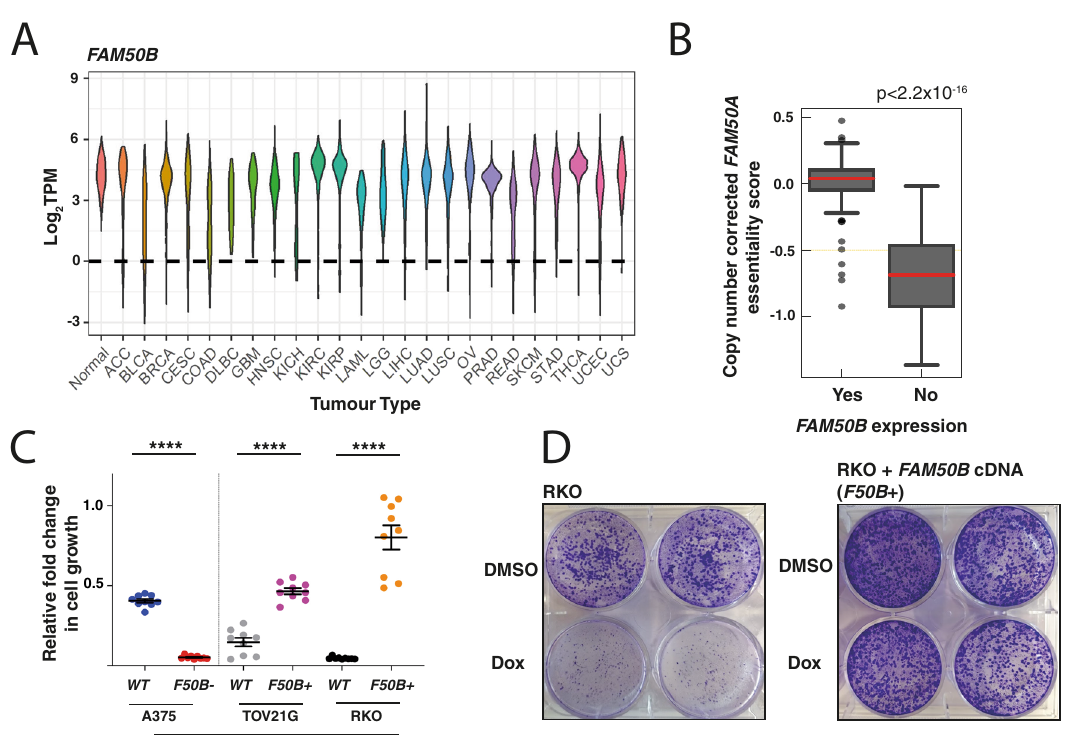
Fig. 3 The FAM50A/FAM50B axis is a targetable synthetic lethal interaction. A Expression of FAM50B across tumour and normal tissue. Data obtained from the TCGA 36 . TPM; transcripts per million. Standard TCGA tumour abbreviations where used. B FAM50B expression inversely correlates with dependency on FAM50A . These data were derived from the analysis of CRISPR essentiality in 275 cancer lines 34 . Lines were categorised by their FAM50B expression using an RPKM cutoff of 1 below which expression was de fi ned as absent. The dependency of FAM50A is shown as scaled log 2 fold-change of FAM50A gRNAs corrected for copy number variation across the cell lines used in this analysis. The p value was calculated with a two-tailed Mann – Whitney U test. Box-and-whisker plots show 1.5× interquartile ranges and 5 – 95th percentiles, centres indicate medians. C Analysis of essentiality using isogenic cell lines. TOV21G-Cas9 and RKO-Cas9, which do not express FAM50B , were transduced with a lentivirus expressing a FAM50B cDNA ( F50B + ). A375-Cas9 cells express both FAM50A and FAM50B . A FAM50B knockout clone was generated for this cell line ( F50B − ) using CRISPR. Cells were transduced with a BFP + lentivirus carrying a gRNA against FAM50A such that 50% of cells were transduced. Cell proportions were analysed at day 4 and 14. The relative fold-change of the infected population is shown. p values were obtained using the unpaired two-tailed t test, **** p < 0.0001. Experiments were performed on three separate occasions in triplicate. Error bars represent the mean and the standard error of the mean (SEM). D Clonogenic con fi rmation of the FAM50A/FAM50B genetic interaction. RKO and RKO- F50B + (complemented with a FAM50B cDNA) were transduced with a lentivirus containing a doxycycline-inducible gRNA against FAM50A (see Methods). The cells also constitutively expressed Cas9 protein. Cells were seeded at 1000 cells/well; doxycycline (Dox; 0.1 µ g/ml)/DMSO was added at 24 h. Cells were fi xed and stained with crystal violet 9 days post seeding. This experiment is representative of three independent biological